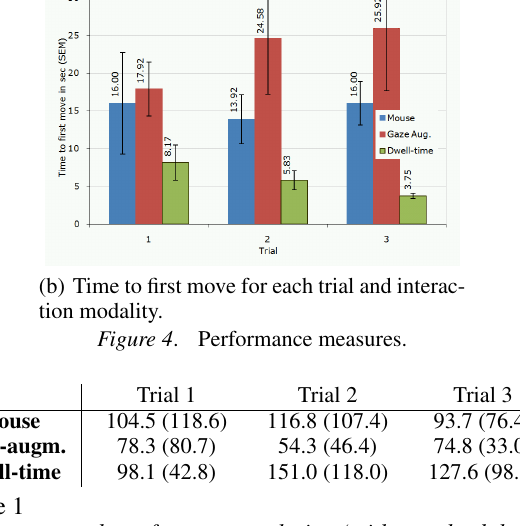
The mean number of moves to solution (with standard devia- tion) during the three trials.